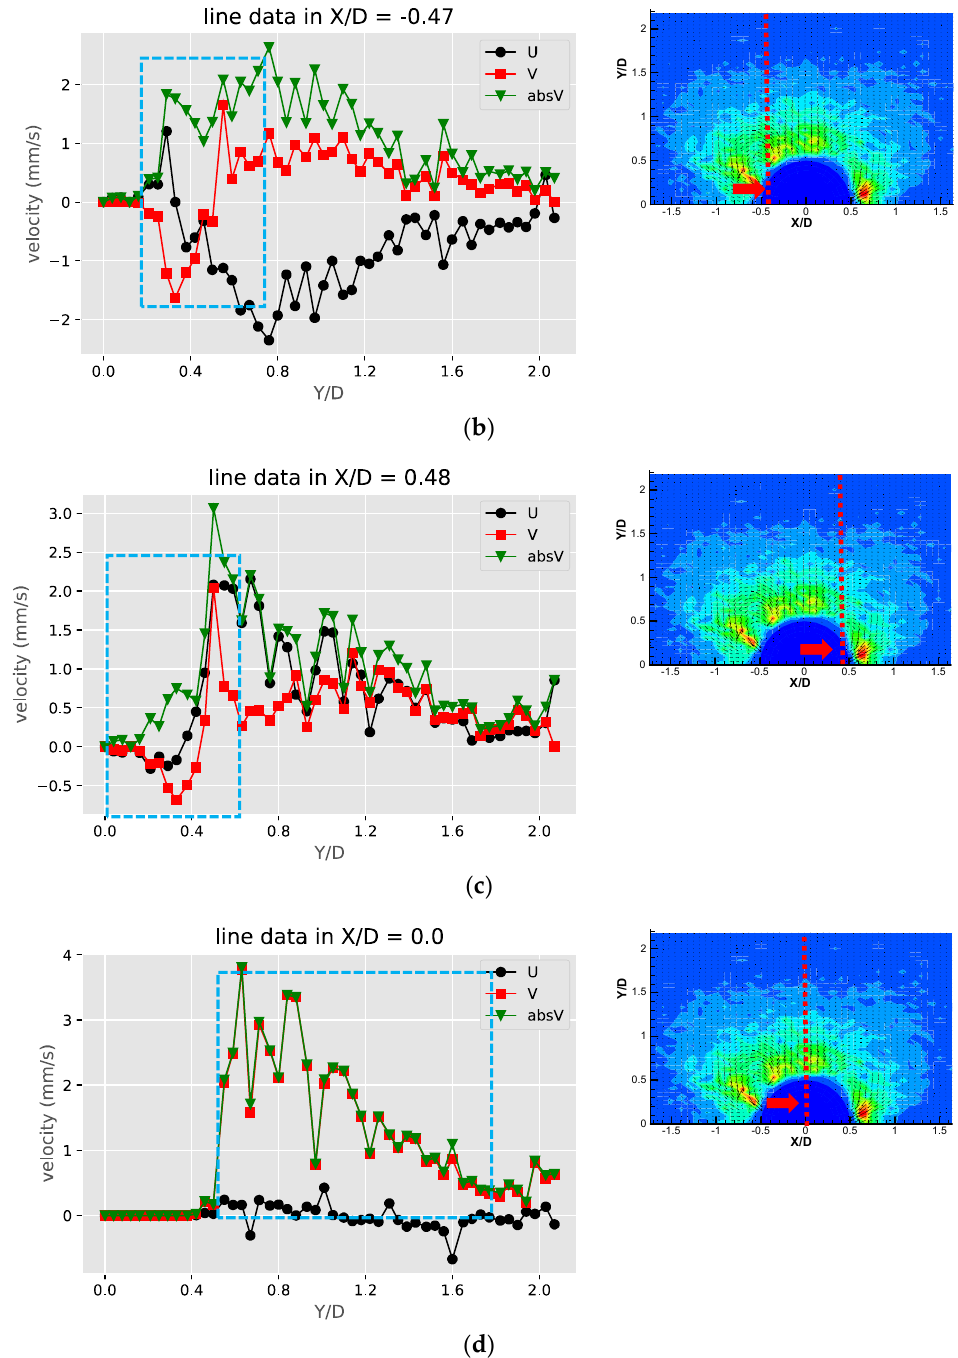
Figure 8. The profiles of velocity components in the X and Y directions (U, V) and absolute velocity (absV) of the gaseous bubble obstructions: ( a ) Y/D = 0.63; ( b )X/D = −0.47; ( c ) X/D = 0.48 and ( d ) X/D = 0.0.